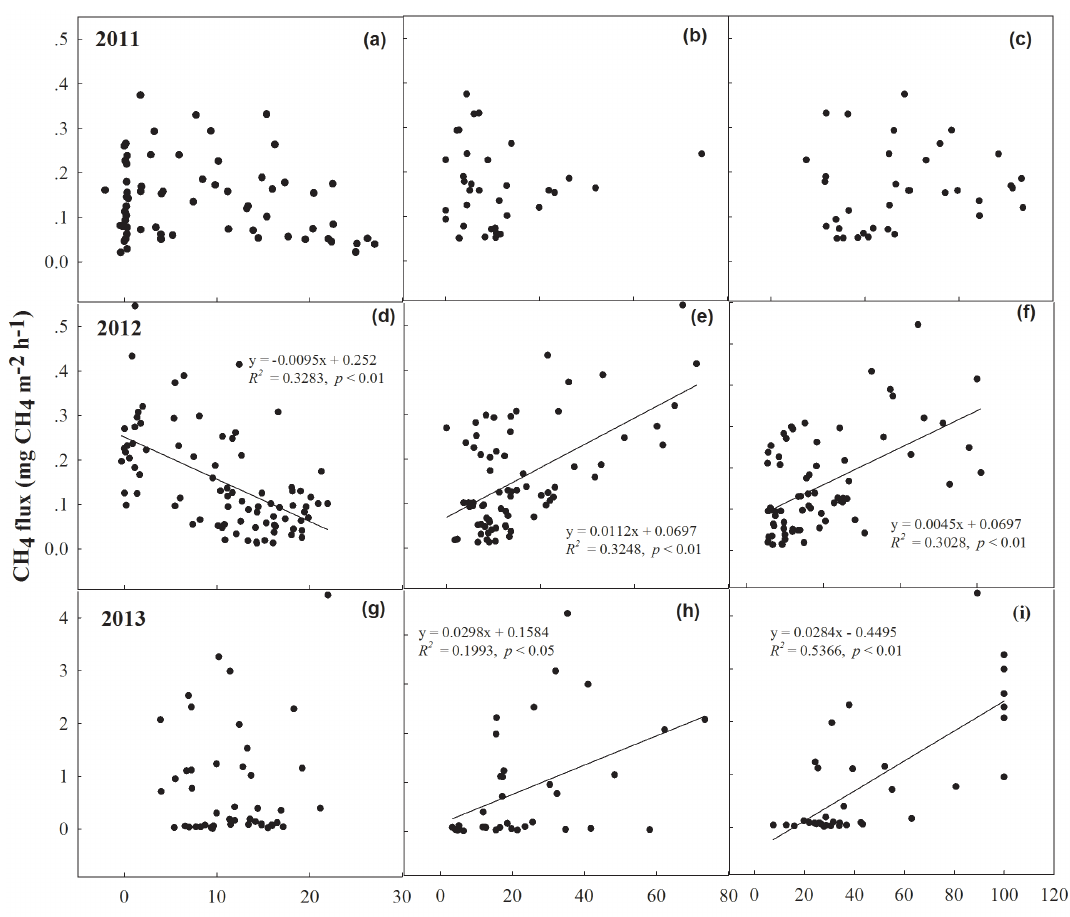
Figure 5. The relationships between mean CH 4 flux and soil temperature at 5cm depth (a, d, g) , soil moisture at 5cm depth (b, e, h) and soil moisture at 10cm depth (c, f, i) ,